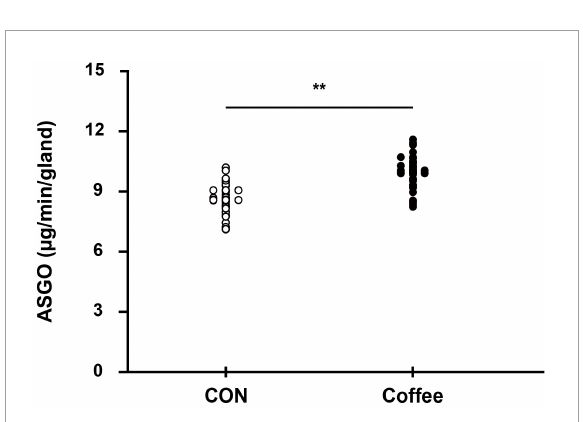
FIGURE5 Comparison of sweating between CON and Coffee subjects showing an active sweat output per gland. Statistical significance difference, ** p < 0.01. CON, no coffee group ( n = 40); Coffee, coffee intake group ( n = 40); ASGO, activated sweat gland